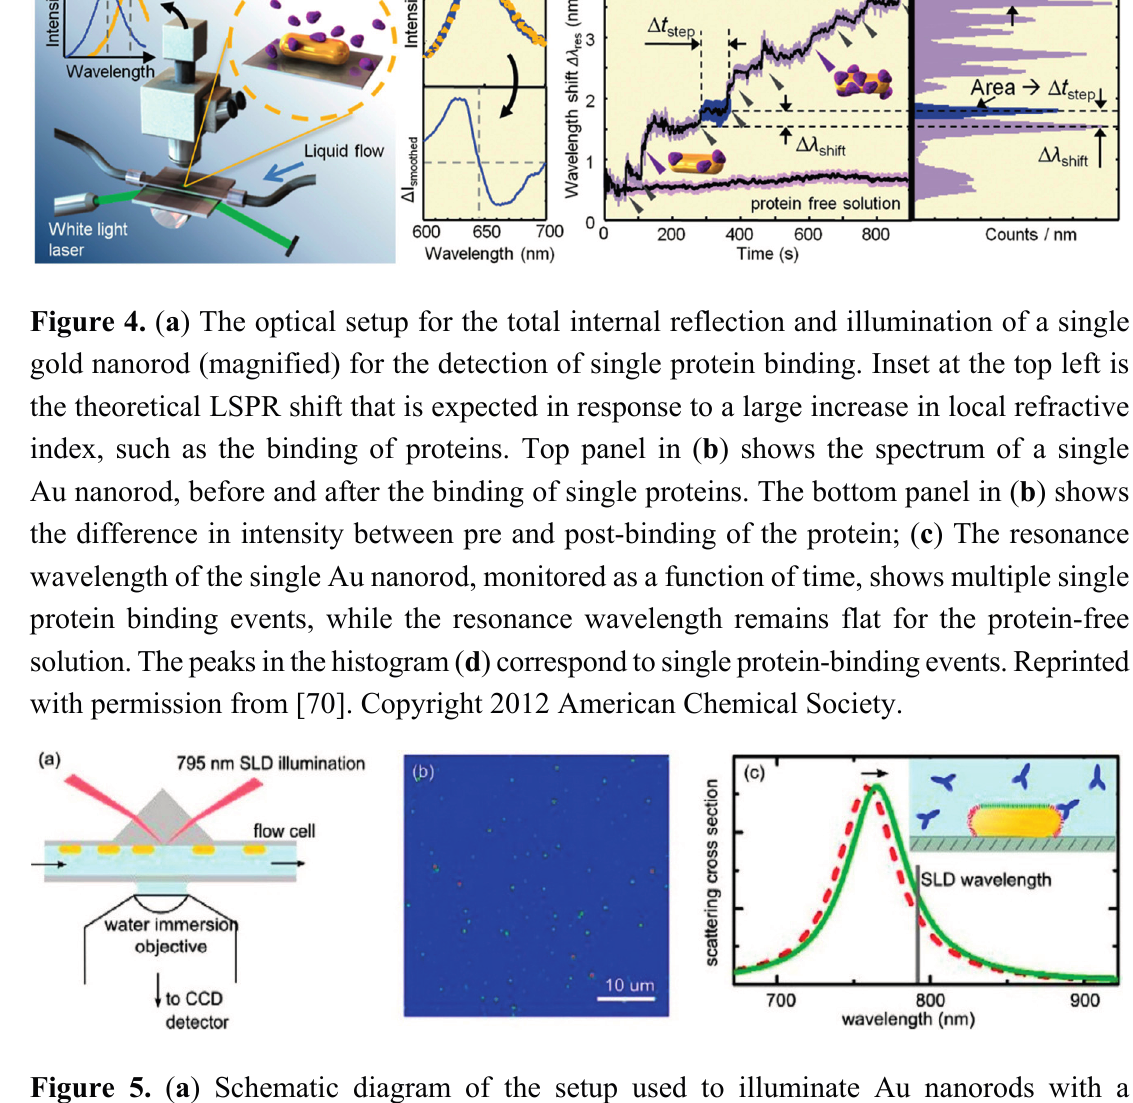
Figure 5. ( a ) Schematic diagram of the setup used to illuminate Au nanorods with a superluminescent diode through a glass prism. ( b ) Image of the modified Au nanorods on the surface obtained with the CCD and ( c ) illustration of the red-shift in LSPR scattering during the binding of proteins to the Au nanorod (inset). Reprinted with permission from [114]. Copyright 2015 American Chemical